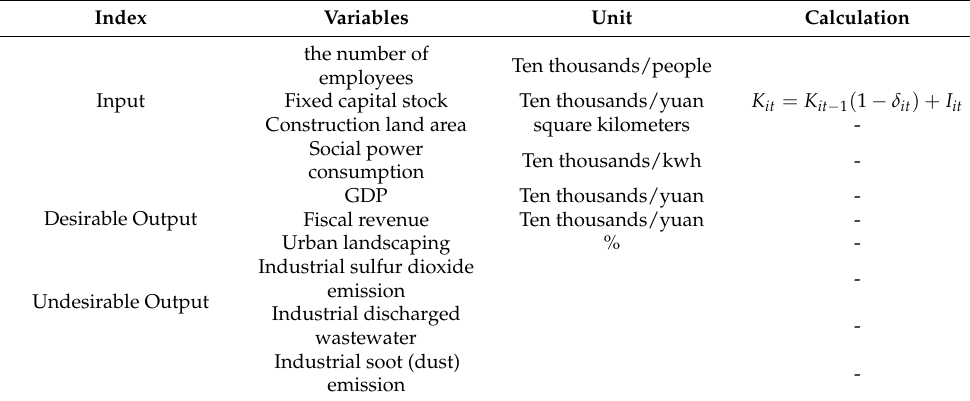
Table 2. Input-output index system of urban